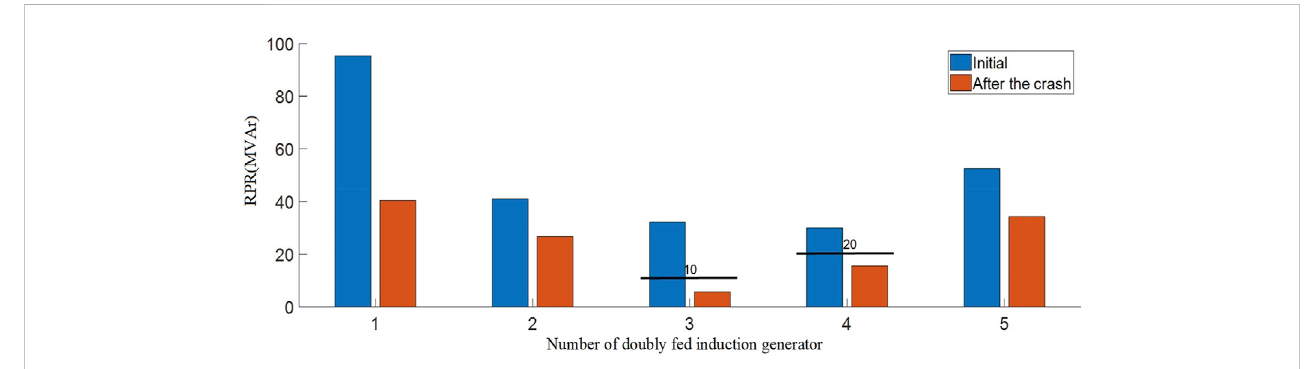
FIGURE 7 The change of RPR after the